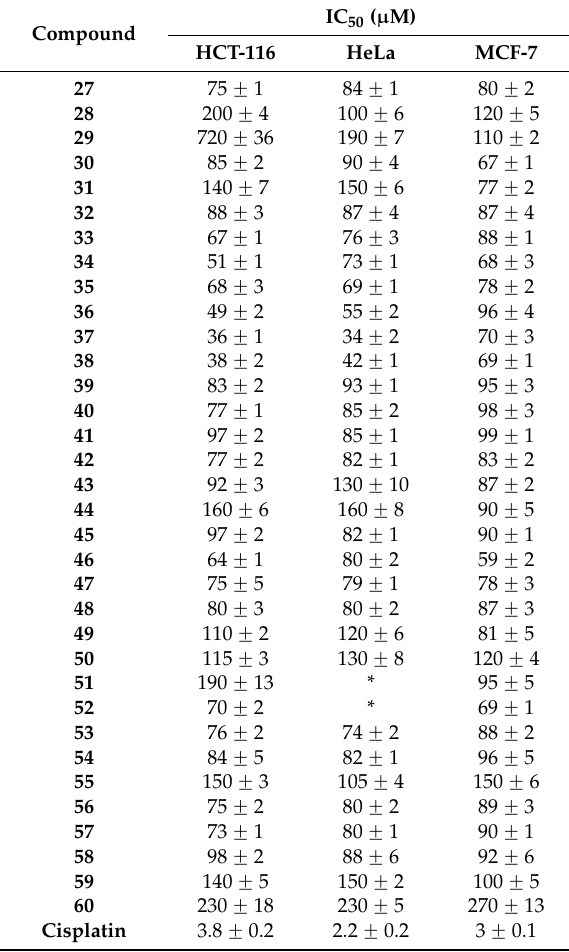
Table 2. Cytotoxicity of compounds 27 – 60 toward human cancer cell lines a